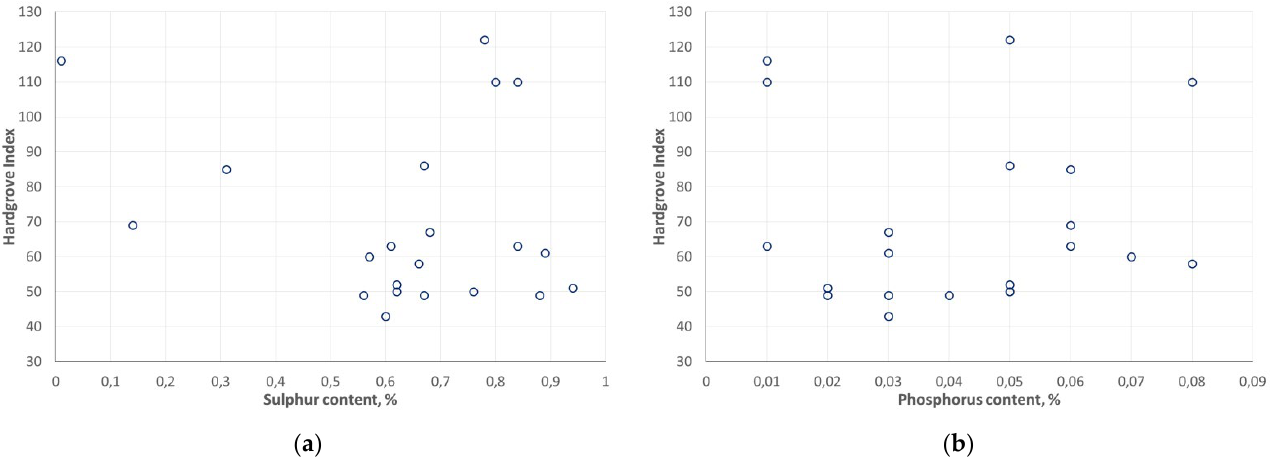
Figure 4. The value of the Hardgrove index depending on the results of proximate analysis of the tested coals: ( a ) ash content and ( b ) moisture content.